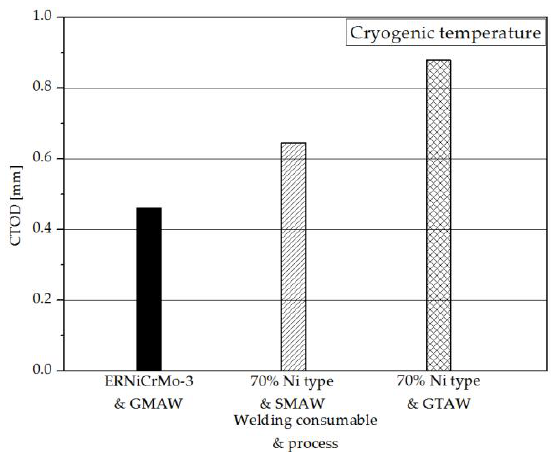
Figure 8. Comparison of the CTOD values of the weldments for other welding processes [17].